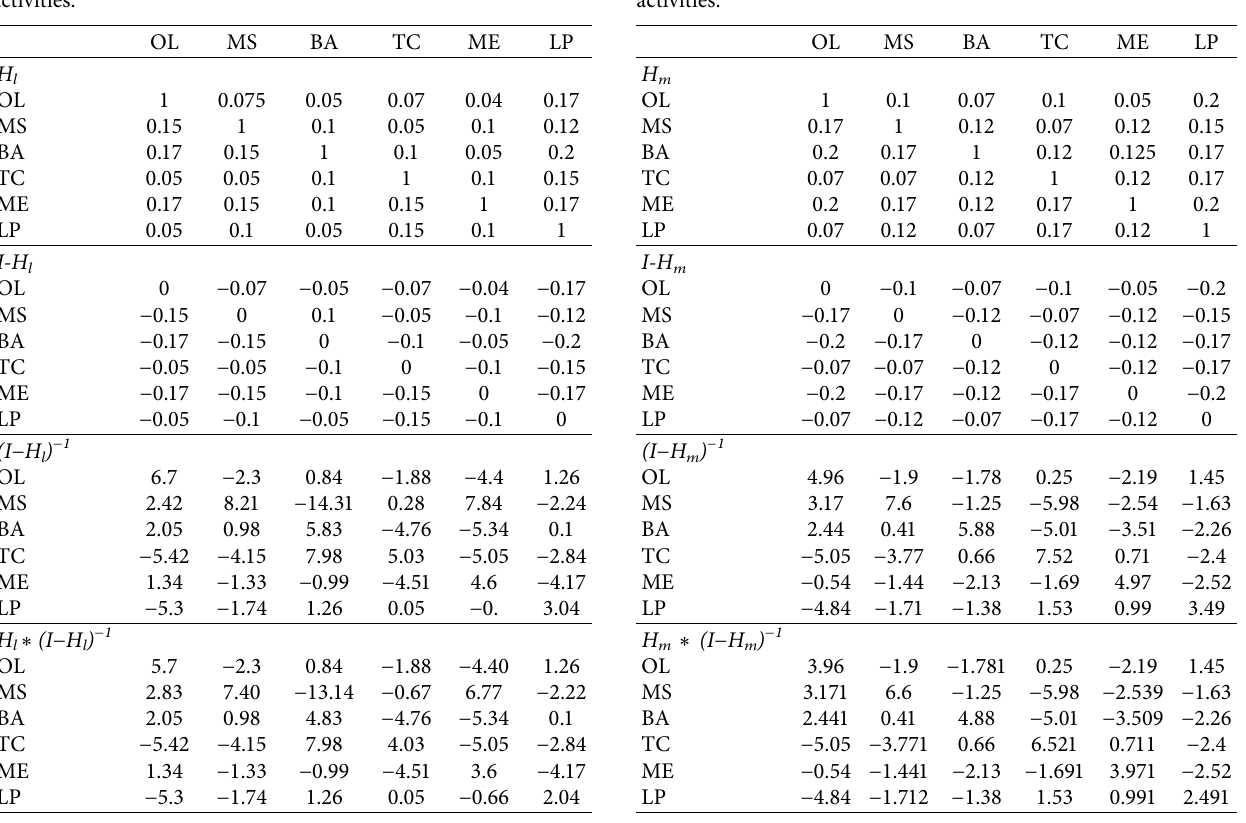
Table 7: Generation of the m matrix of general relationships for